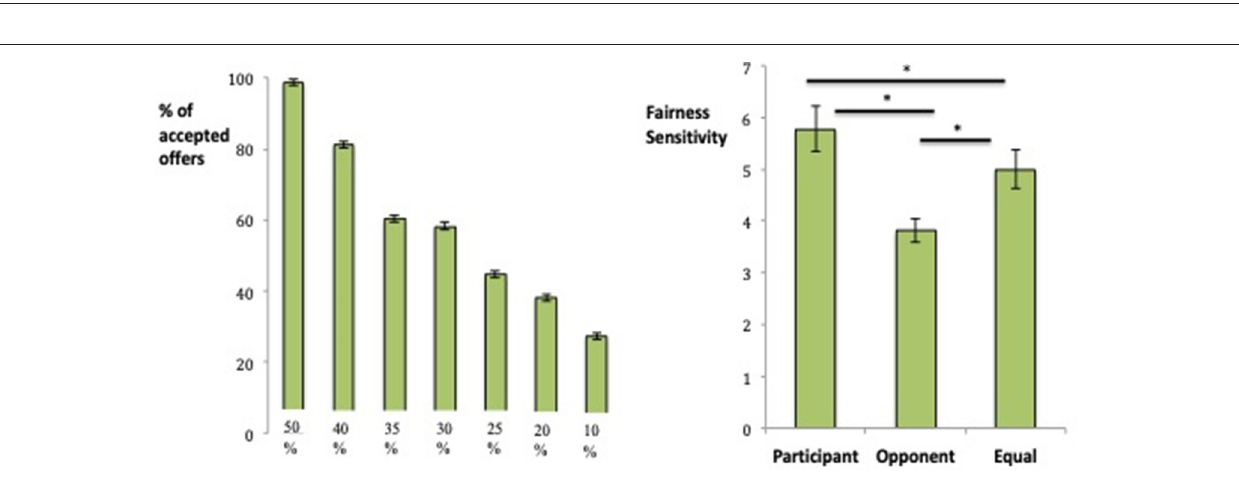
FIGURE 4 | Main effect of Offer at each level of fairness (left) and fairness sensitivity for each Contribution type (right) on the Ultimatum Game. *Indicates a significant difference between